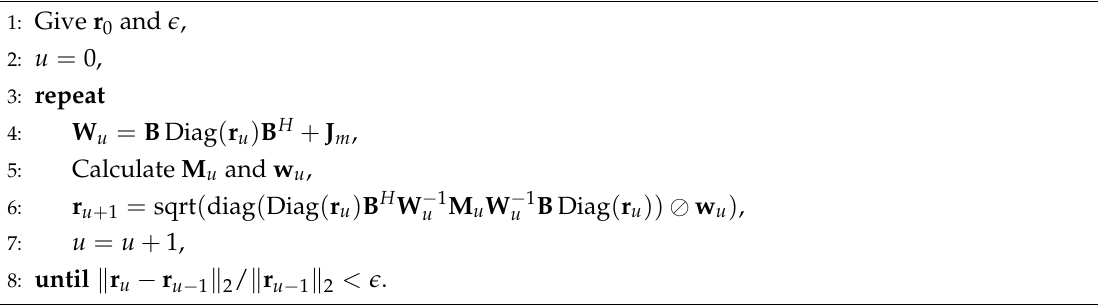
Algorithm 3 The MM2 algorithm for spatially non-uniform white